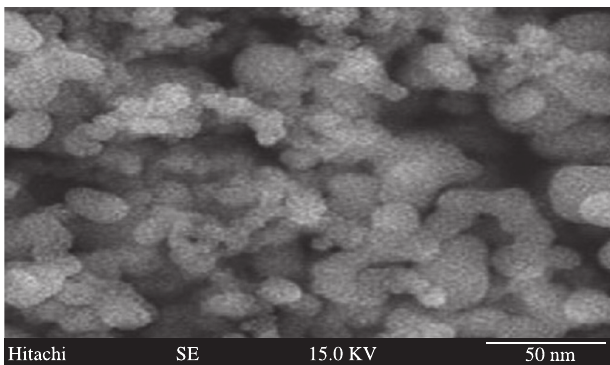
Figure 2. SEM micrograph of ZrO 2 Table 1. Chemical and physical properties of Portland cement wt. (%). Material